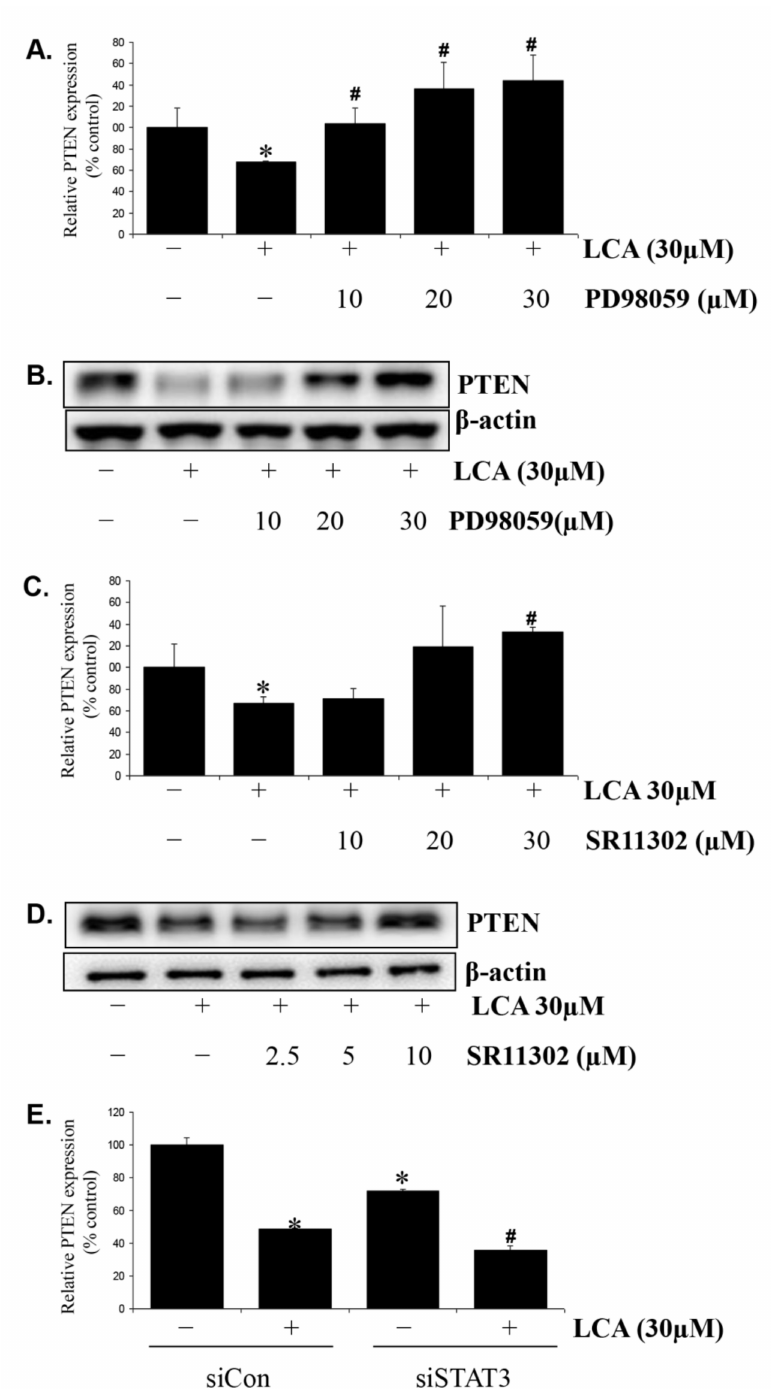
Figure 6. LCA inhibits PTEN expression via signals involved in the LCA-induced miR21 mechanism, Erk1/2-AP-1 and STAT3. HCT116 cells were treated with PD98059 at 10 µ M–30 µ M for 1 h prior to 30 µ M LCA treatment for 24 h. The cells were then harvested and checked for PTEN expression by Realtime-PCR ( A ) and Western blot ( B ). HCT116 cells were treated to SR11302 at 10 µ M–30 µ M concentration for 1 h prior to LCA treatment and then subjected to check PTEN expression by Realtime-PCR ( C ) and Western blot ( D ). ( E ) HCT116 cells were transfected to 50 nM control siRNA (siCon) or siSTAT3, and then treated with 30 µ M LCA for 24 h. The cells were further extracted for total RNA and checked for PTEN expression by Realtime-PCR. * p < 0.05 versus control; # p < 0.05 versus only LCA. The above data represent the means ± SD from triplicate